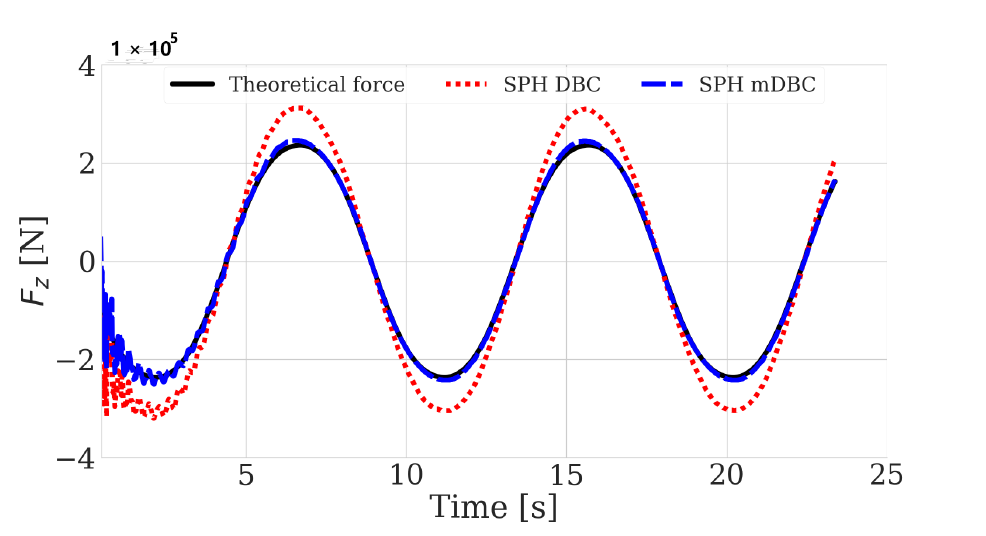
Figure 4. Vertical force F z acting on a sphere with prescribed heave motion, a = 1.5 m T = 9 s.